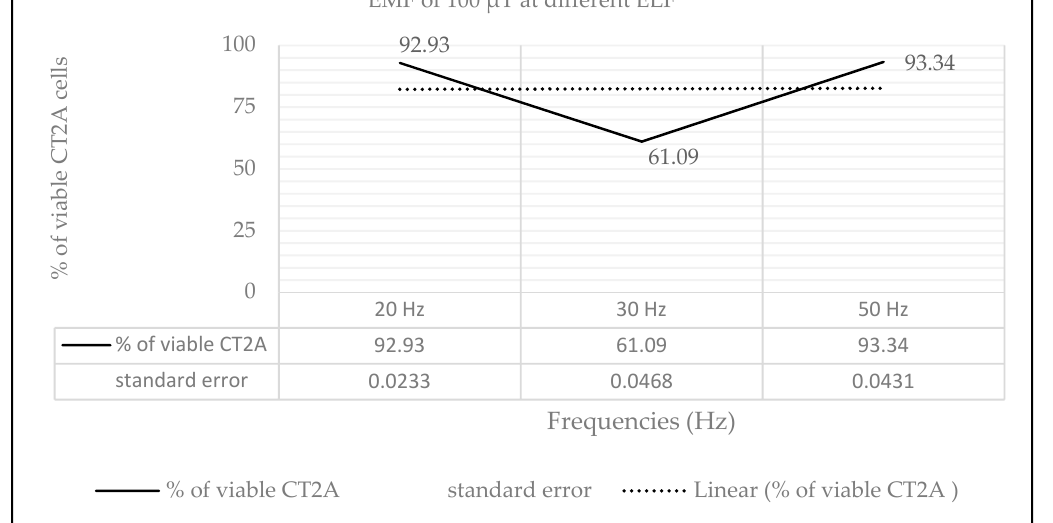
Figure 2. Graphical representation of % of viable CT2A cells after the exposure during seven days to an intermittent EMF of 100 μ T at different ELFs: 20, 30, and 50 Hz.